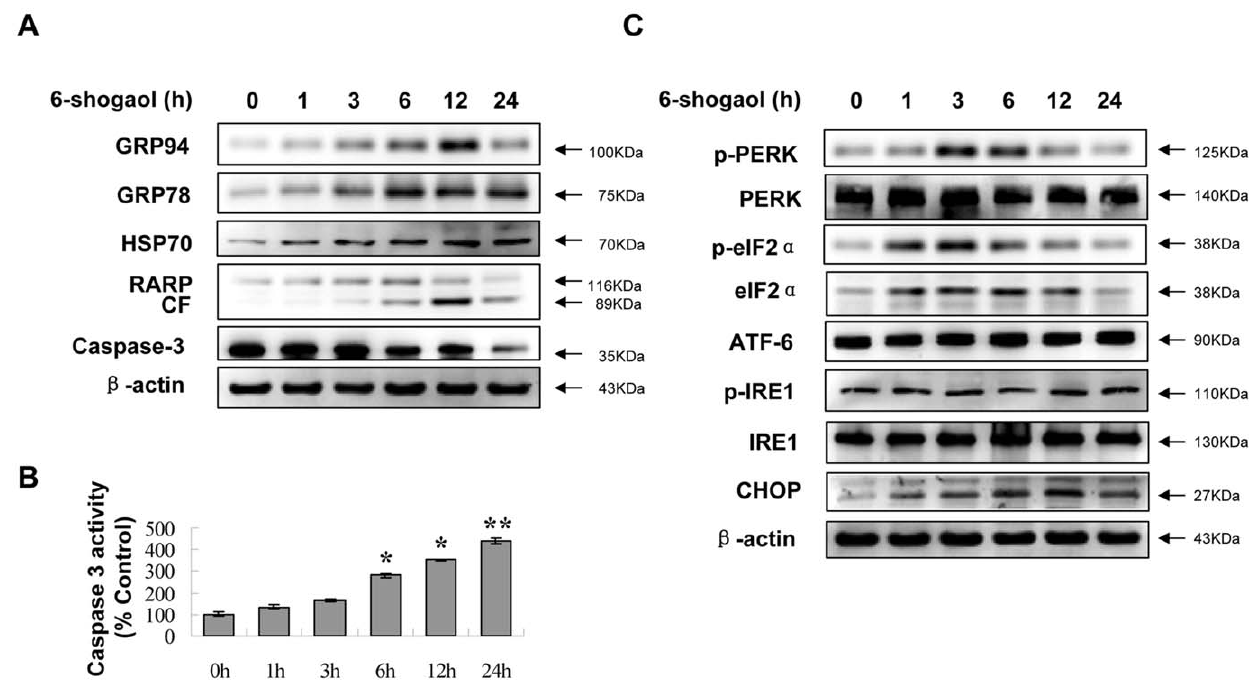
Figure 3. Effects of 6-shogaol on ER stress signaling proteins. The cells were treated with or without 20 m M 6-shogaol for 1, 3, 6, 12, and 24 h. Total cellular extracts were prepared and subjected to Western blot analysis using antibodies against PARP, caspase-3 and ER stress-related molecular chaperones (A) and ER stress related proteins (C). CF stands for cleavage fragments of PARP. The caspase-3 activity (B) was assayed according to Caspase-3 Activity Assay Kit. *Values for cells treated with 6-shogaol were significantly greater than the control group by Student’s t -test ( P , 0.05); **( P , 0.01).